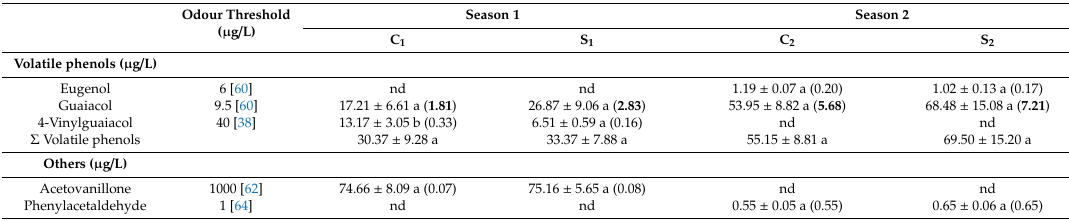
C 1 : control wine (from untreated grapevines); S 1 : wine from grapevines treated by spraying 1; C 2 : control wine (from untreated grapevines); S 2 : wine from grapevines treated by spraying 2. The mean values (n = 2) are shown with their standard deviations. For each compound and season, di ff erent letters indicate significant di ff erences according to the independent samples t-test ( p < 0.05). nd: not detected. Odour activity values (OAV) are shown in parentheses for each compound and wine. Bold OAV values indicate the compounds with concentrations above their odour threshold. Reference numbers for the odour thresholds (in wine or synthetic wine) are shown in square brackets for each